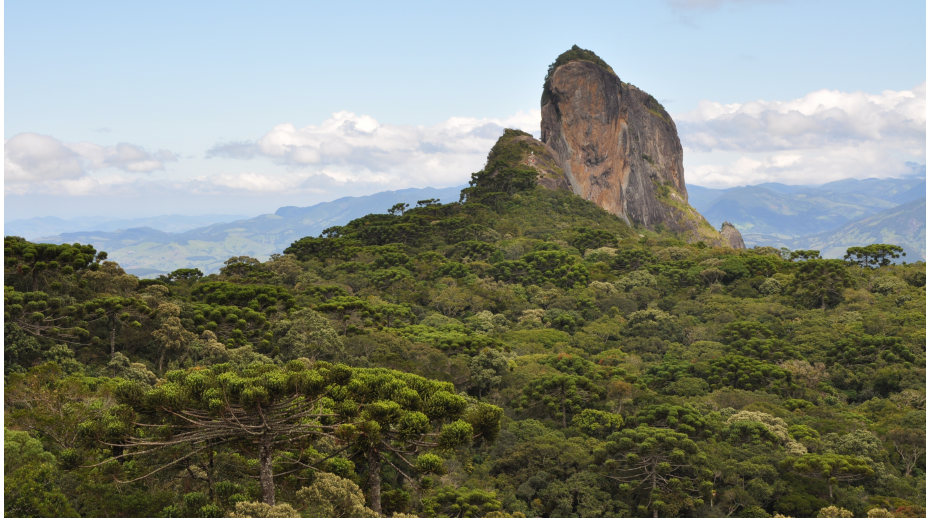
Figure 1. Samples of Araucaria angustifolia located at Pedra do Baú , 2013. The Campos do Jordão city was selected for this study due to (i) its geographical posi- tion and altitude; (ii) being an endemic region for the Araucaria angustifolia trees; and (iii) the tree’s longevity. Campos do Jordão city is an Environmental Protection Area (Ordinary Law No. 4105, dated 26 June 1984), which is located at the east of the São Paulo Capital, in Serra da Mantiqueira (Figure 2), at an altitude of 1597 m (more information in http://www. camposdojordao.sp.gov.br/portal/index.php/cidade/informacoes/localizacao (accessed on 8 May 2012). Prefeitura de Campos do